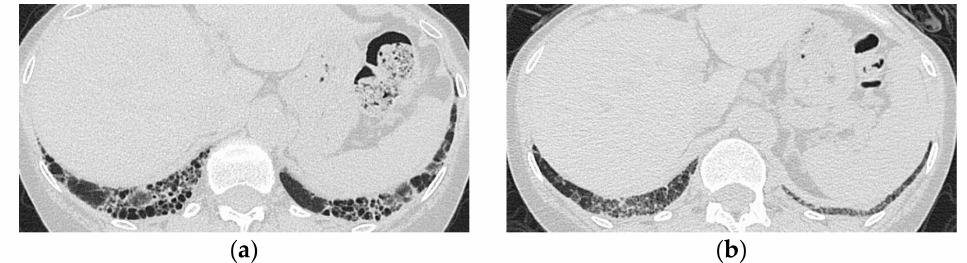
Figure 6. A 59-year-old woman with dermatomyositis under long-term follow-up. The most recent high-resolution computed tomography (HRCT) ( a ) shows bilateral honeycomb-like cystic lesion just below the pleura, and a review of the HRCT scan at the time of initial presentation 17 years ago ( b ) shows that the same area was previously ground-glass opacification with mild reticulation showing NSIP pattern.